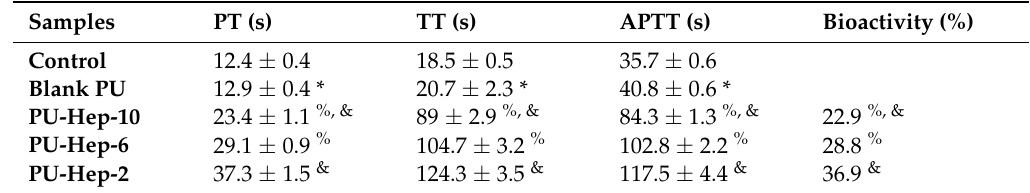
Table 1. Coagulant time (prothrombin time (PT), thrombin time (TT), activated partial thromboplastin time (APTT), and heparin bioactivity of PU and heparinized PU films.